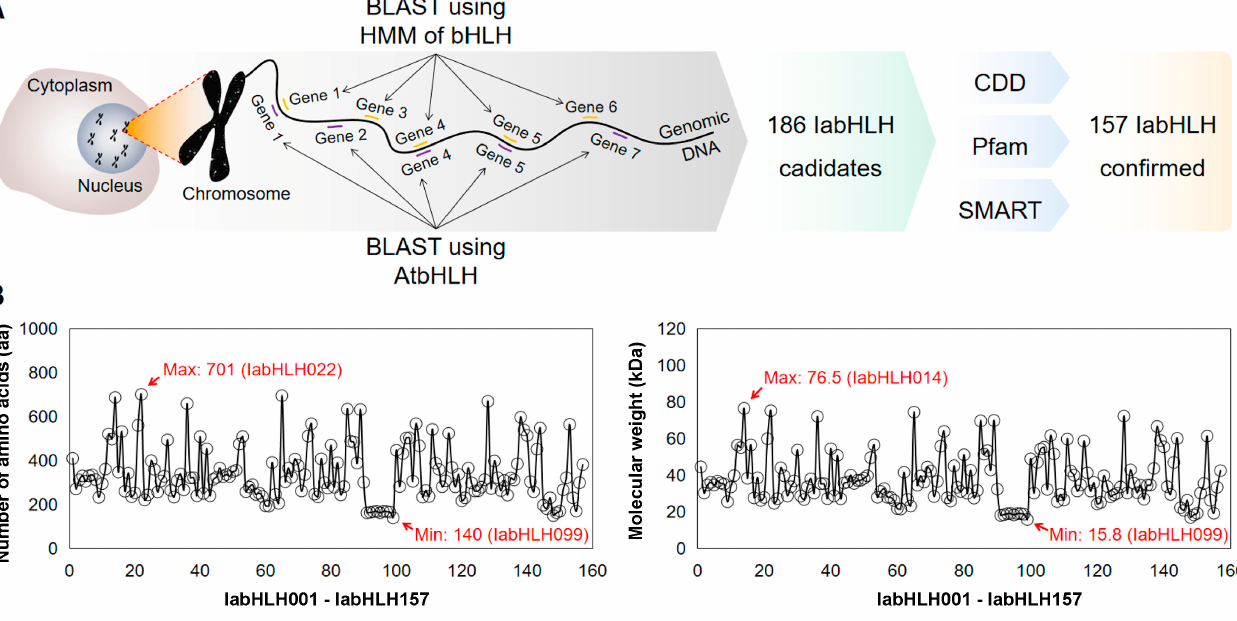
Figure 1. Identification of IabHLH genes. ( A ) Schematic diagram of the procedure for retrieving IabHLH genes from the I. aquatica genome. ( B ) The physicochemical properties of 157 IabHLH pro- teins. 2.2. Synteny Analysis of IabHLHs To understand the IabHLH gene distribution in the I. aquatica genome, their genomic location was analyzed. A total of 129 of the 157 IabHLH genes were unevenly distributed on 15 chromosomes, while the remaining genes were spread on the scaffolds (Figure 2A and Table S1).